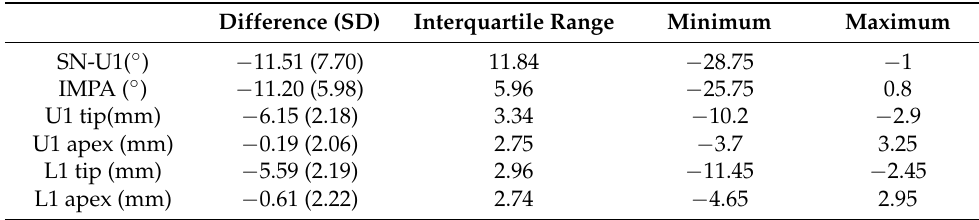
Table 2. Mean cephalometric changes after treatment (T1–T0).